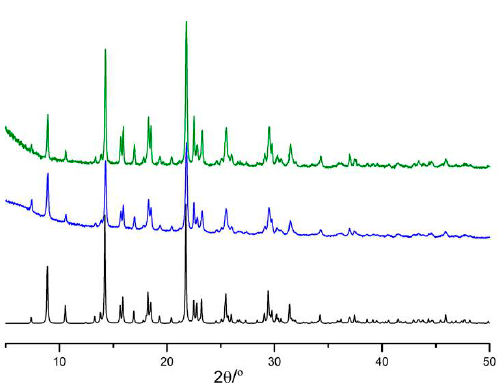
Figure 7. Powder X-ray diffractograms of complex I recorded after mechanochemistry (in blue) and after 5 months on a shelf (in green), at ambient condition, compared to the respective simulated diffractogram (in black).